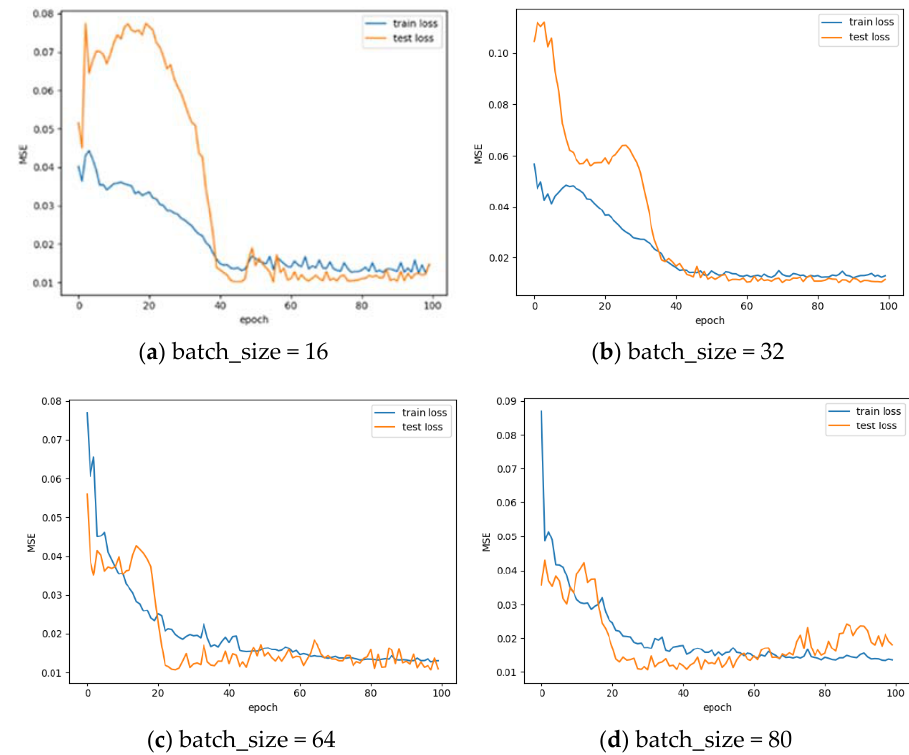
Figure 2. Parameter batch_size adjustment experiment. We set batch_size to 16, 32, 64, and 80 for comparative experiments.